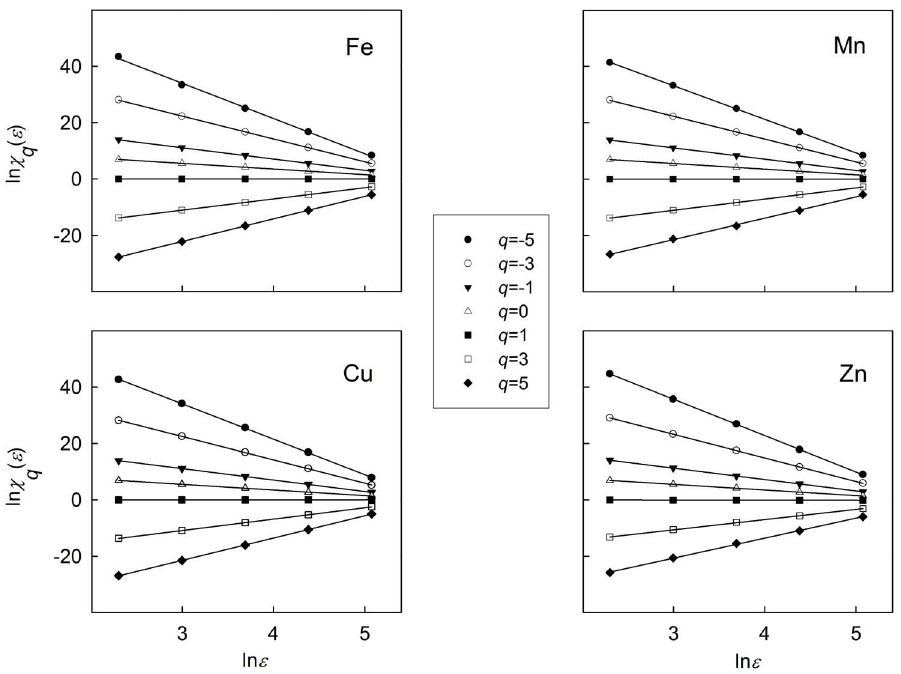
Figure 1. Logarithms of partition functions of selected soil trace elements plotted against scales. The R 2 values of the linear fit for all q considered were always greater than 0.99.